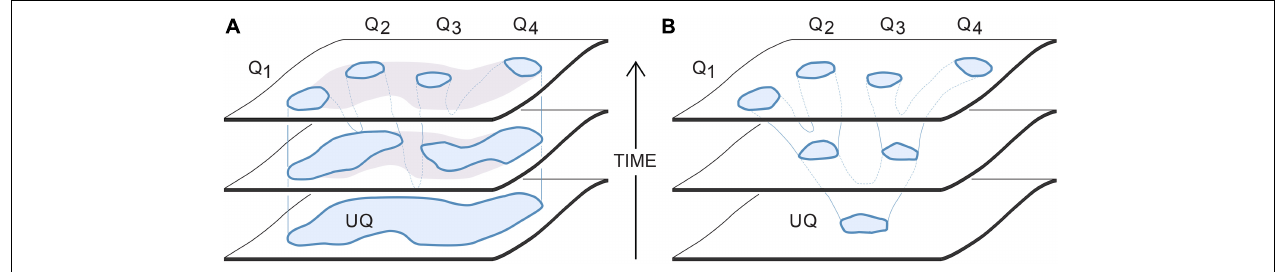
FIGURE 3 | Two options for how a set of domains on SC-space, representing the SCs that evoke specific qualia (the Qs), could derive by common descent from those evoking a single ur-quale (UQ). The intent is to show how the ur-quale is changed in character (horizontal axis) over evolutionary time (vertical axis). (A) The evaporating puddle scenario: this assumes an ur-quale whose SCs occupy a large domain, which is not then precisely defined at first with regard to the experiences those SCs evoke. A range of sensations would hence be evoked together from which the descendant qualia are progressively refined. Since the SCs remain within the parent domain, each newly evolved quale would incorporate elements present in the ur-quale. (B) The branched tree scenario: this assumes the SCs evoking the single ur-quale were distinct and well defined from the start, so the initial point cloud would have been restricted to a smaller domain compared with the puddle scenario. Since the branches of the tree diverge, all of the Qs in the tree scenario (in this example, all but Q3) will differ qualitatively from the ur-quale from which they all derive. See text for